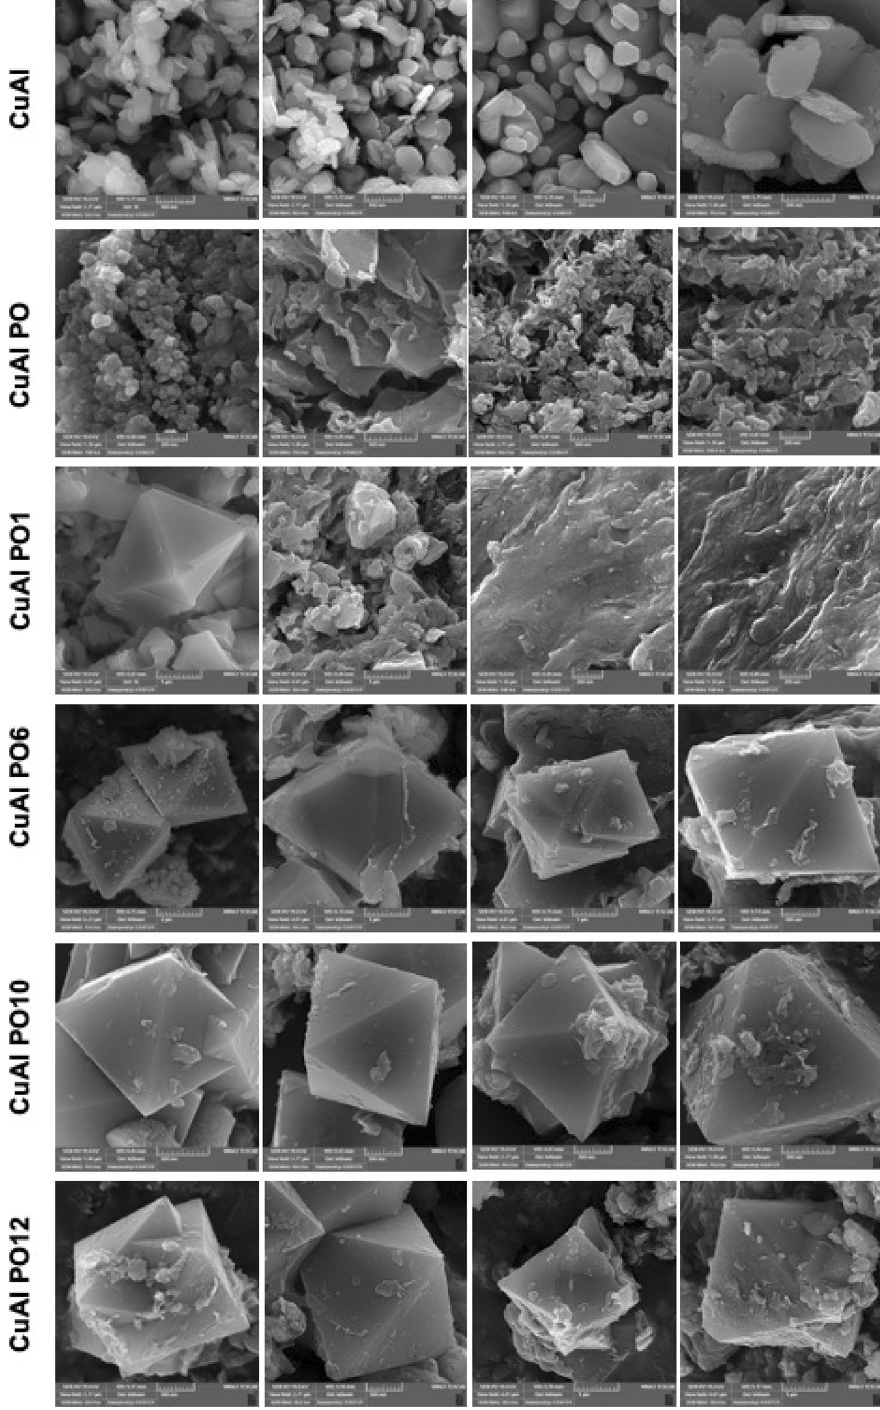
Figure 2. FESEM images of the of the CuAl LDH, CuAl PO LDH, CuAl PO1 LDH, CuAl PO6 LDH, CuAl PO10 LDH and CuAl PO12